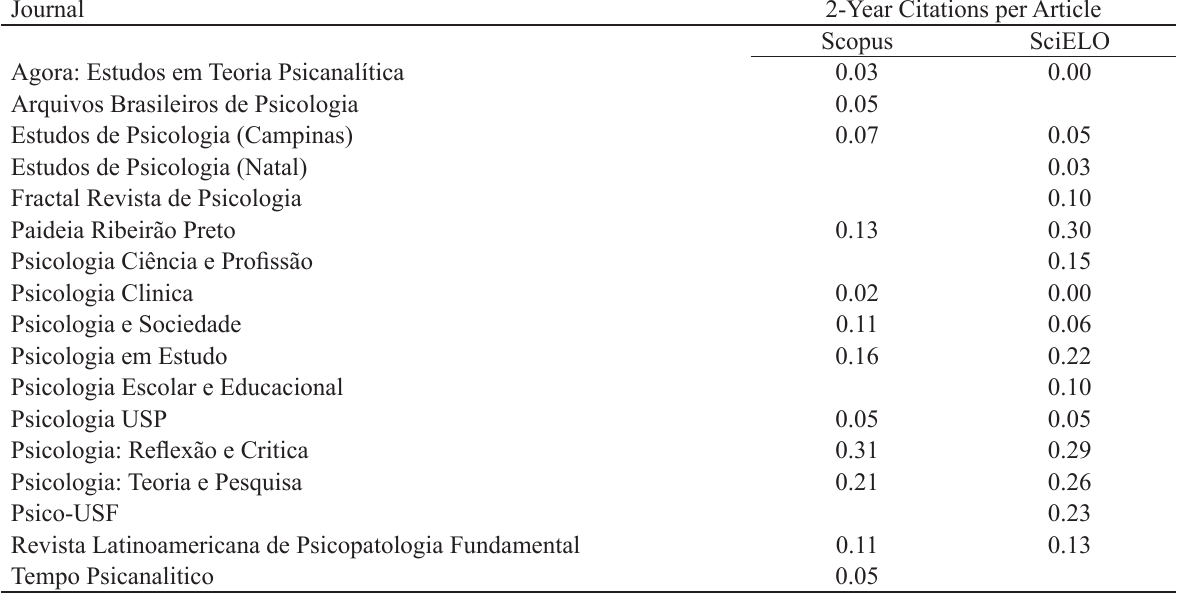
Note . Data sources: Scopus and SciELO.